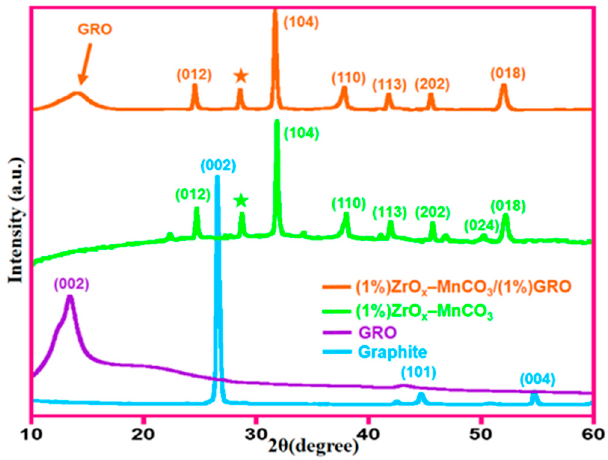
Figure 1. XRD patterns of graphite, GRO, (1%)ZrO x –MnCO 3 , and (1%)ZrO x –MnCO 3 /(1%)GRO.